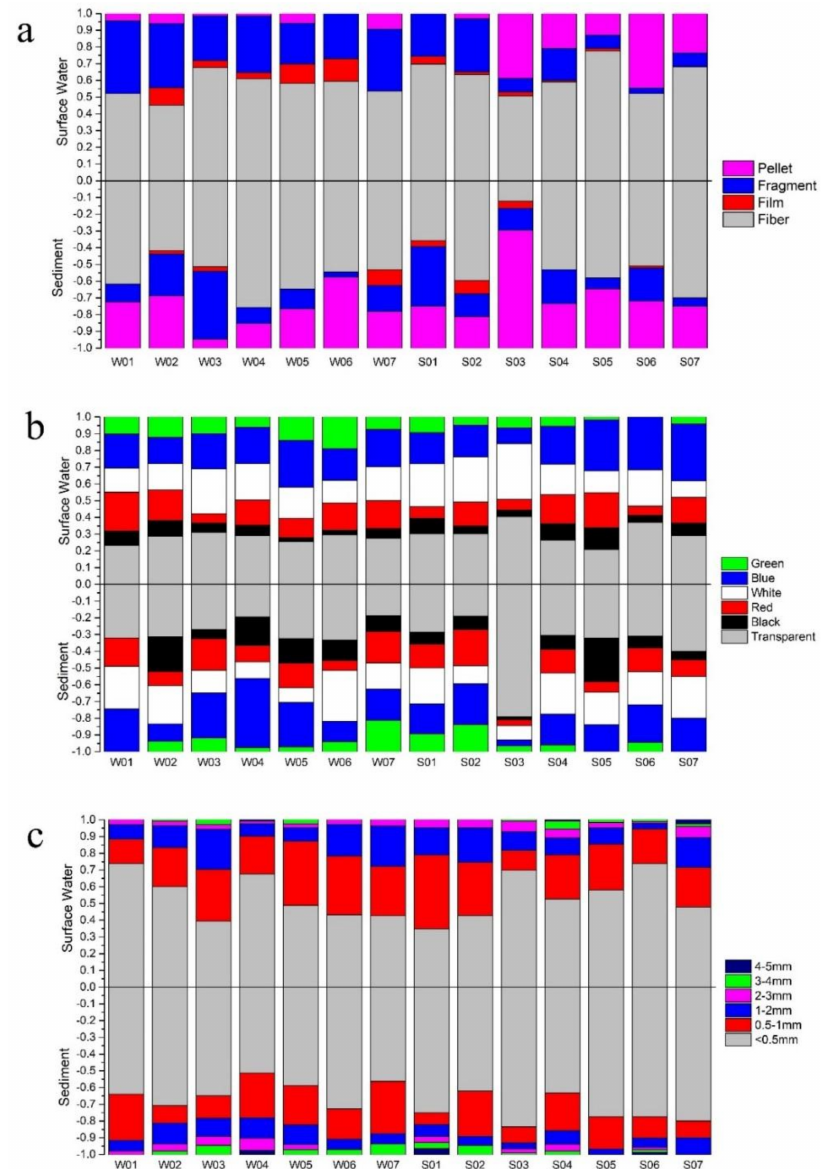
Figure 3. Proportion of ( a ) shape distribution ( b ) color distribution and ( c ) size distribution of microplastics in lakeshore